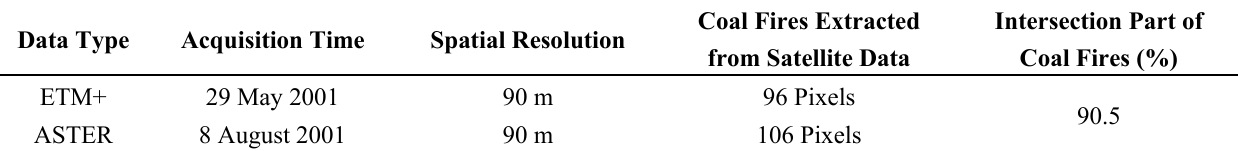
Figure 8. Cross-validation of coal fire information that was extracted from 2001 Landsat and ASTER imageries, the two-year’s worth of coal fires were stacked for overlay analysis. Table 2. Cross-validation of the coal fires from Landsat and ASTER